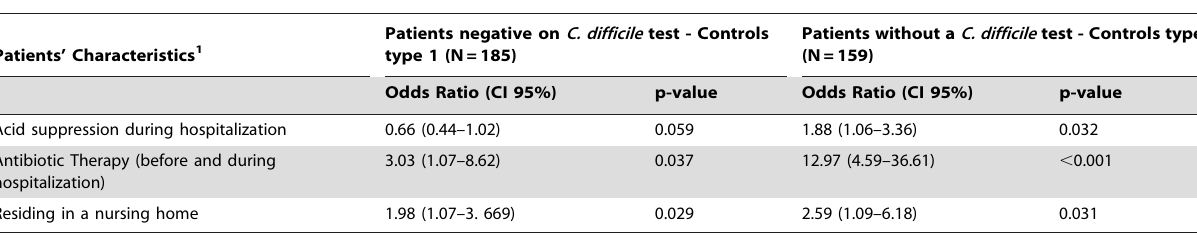
Table 5. Factors affecting C. difficile infection, results of a multivariate analysis by conditional logistic regression.